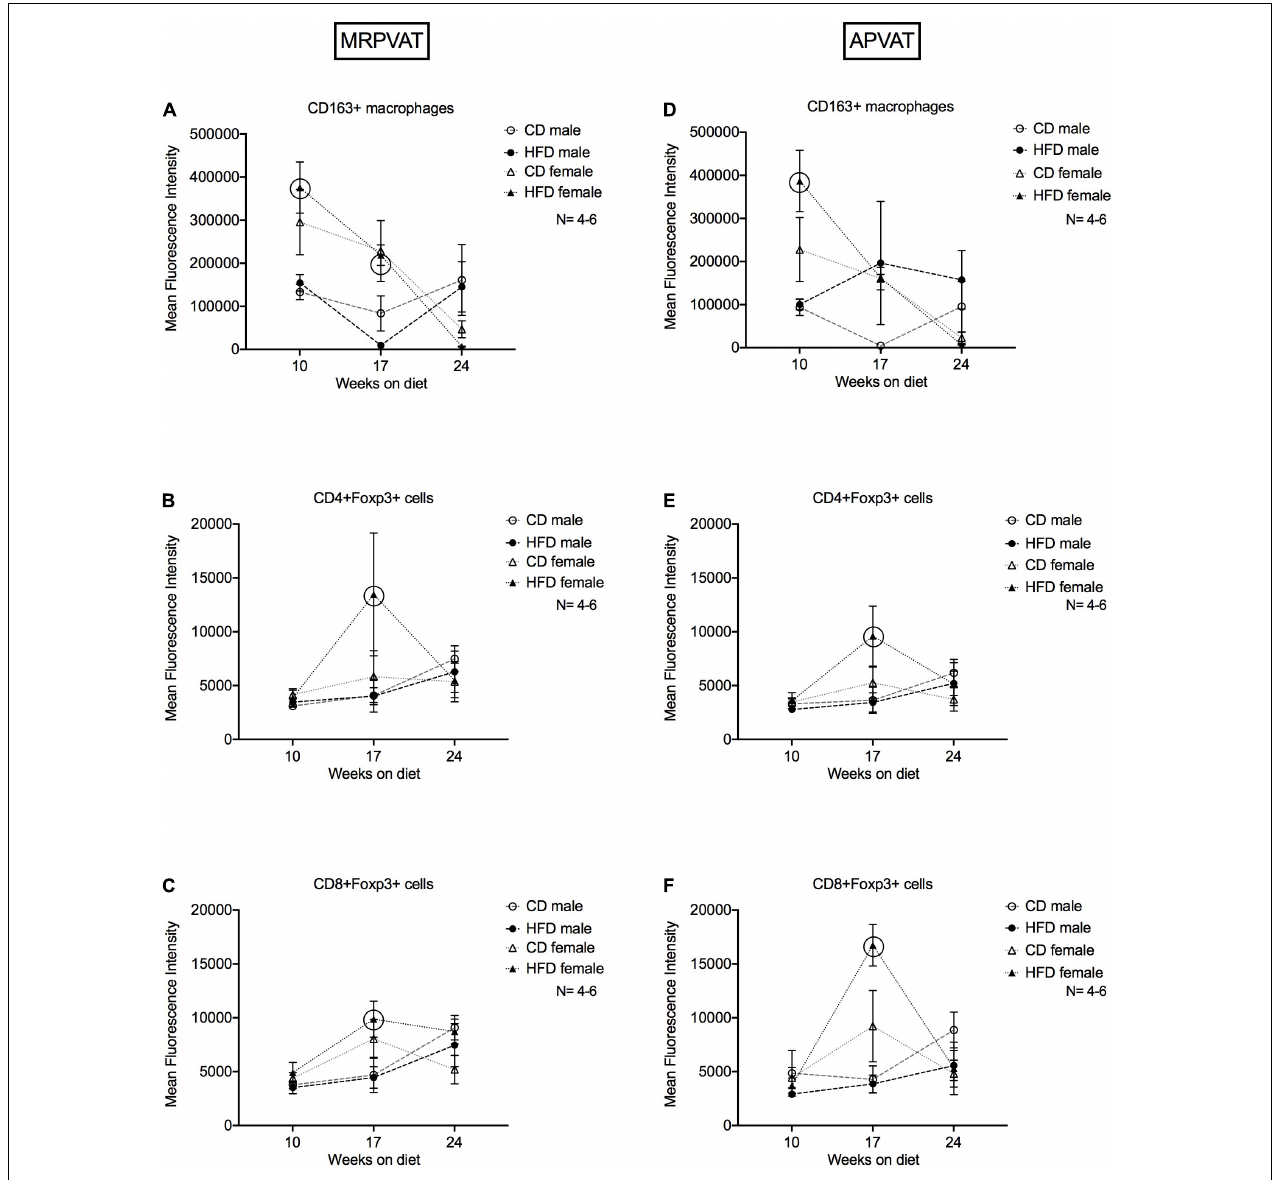
FIGURE 6 | Magnitude of expression of markers of M2-like macrophages and T regulatory cells over the time course of hypertension development and progression. Mean fluorescence intensities (MFI) of CD163 on CD163 + M2-like macrophages (A,D) , Foxp3 on CD4 + (B,E) and CD8 + (C,F) T regulatory cells in MRPVAT and APVAT of both sexes over the time course on diet were quantified by flow cytometry. Points represent means ± SEM of the magnitude of expression (measured by MFI) of the specified marker. Number of animals is indicated by N. A P < 0.05 by two-way ANOVA with Tukey’s test for multiple comparison, was considered statistically significant. Circles in the graph represent a significant difference in MFI between the sexes within a diet at a given time